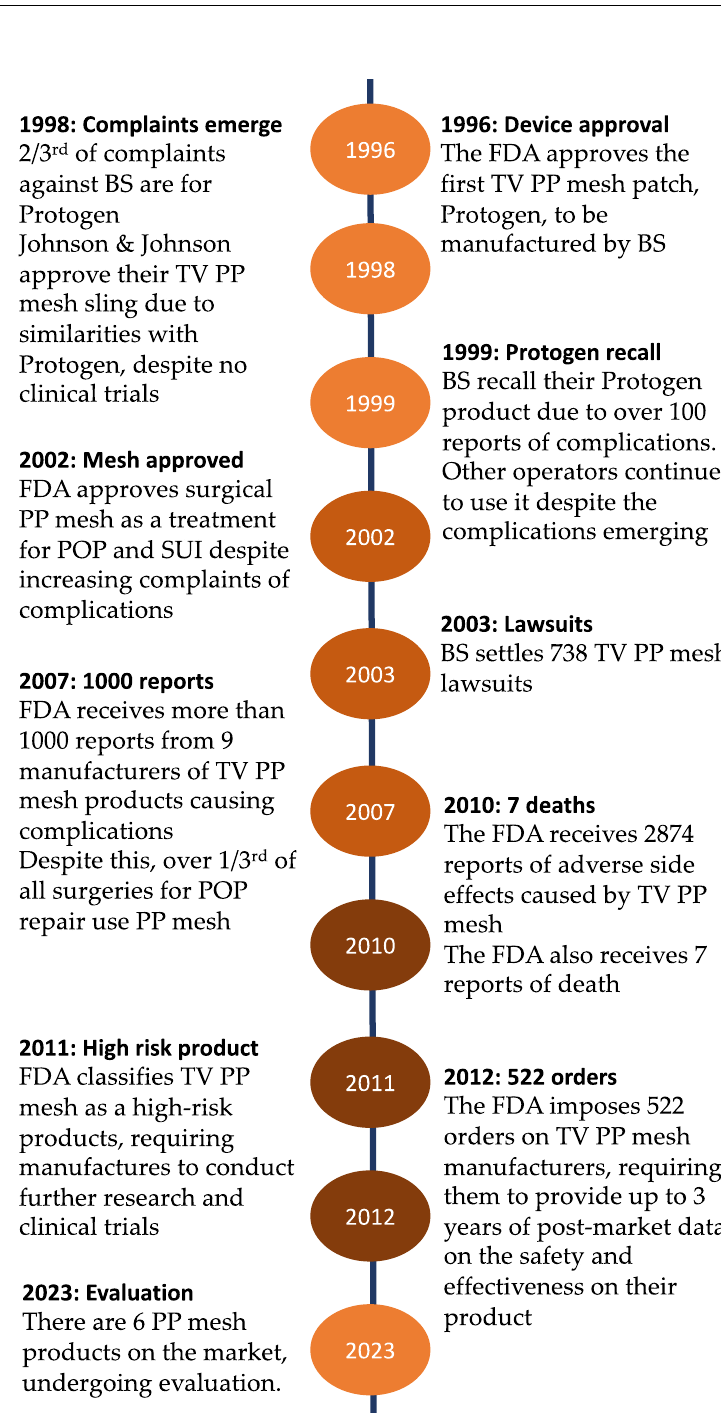
Figure 1. Timeline depicting major events that have taken place since the first introduction of the polypropylene pelvic mesh. Boston Scientific (BS), Polypropylene (PP), transvaginal (TV).